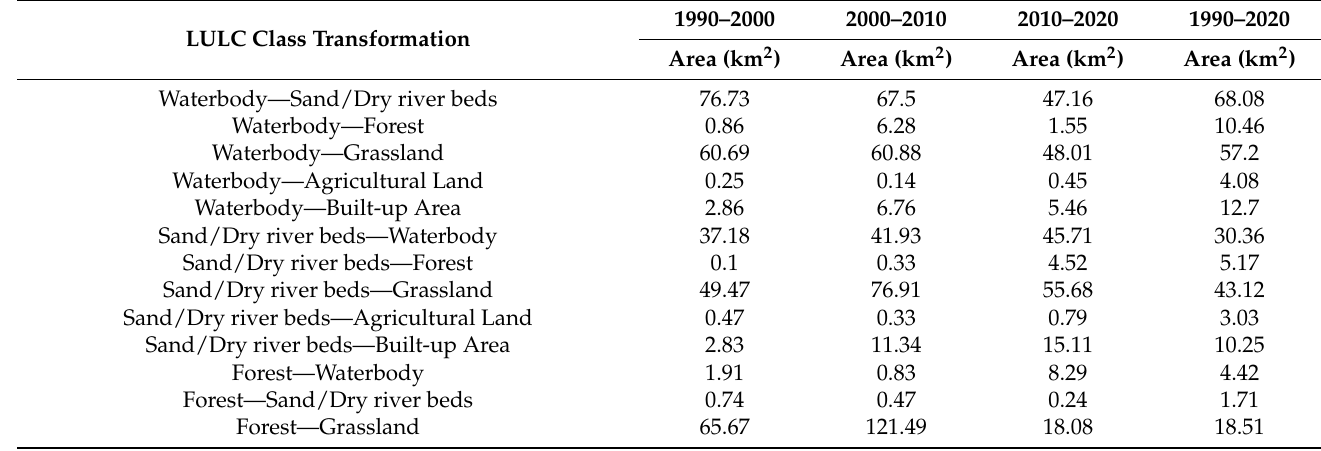
Table 4. Period-wise transformations of LULC class of the Kaziranga eco-sensitive zone. LULC Class